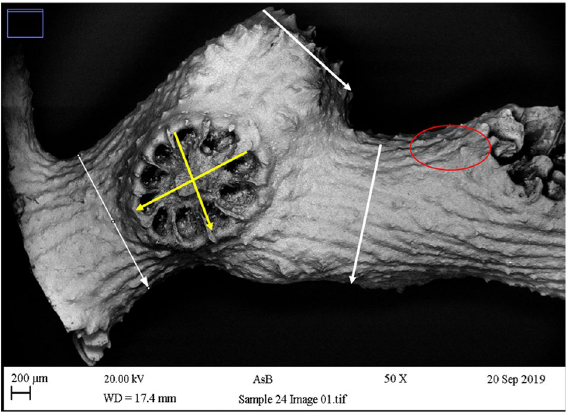
Figure 2. Example of scanning electronic microscopy-SEM analysis for the genus Madracis and measurements (program Image J) used for taxonomic identification. White lines correspond to measurements of the branches. Yellow lines are the measurements of the corallite. The red circle shows the presence of spines in the coral.